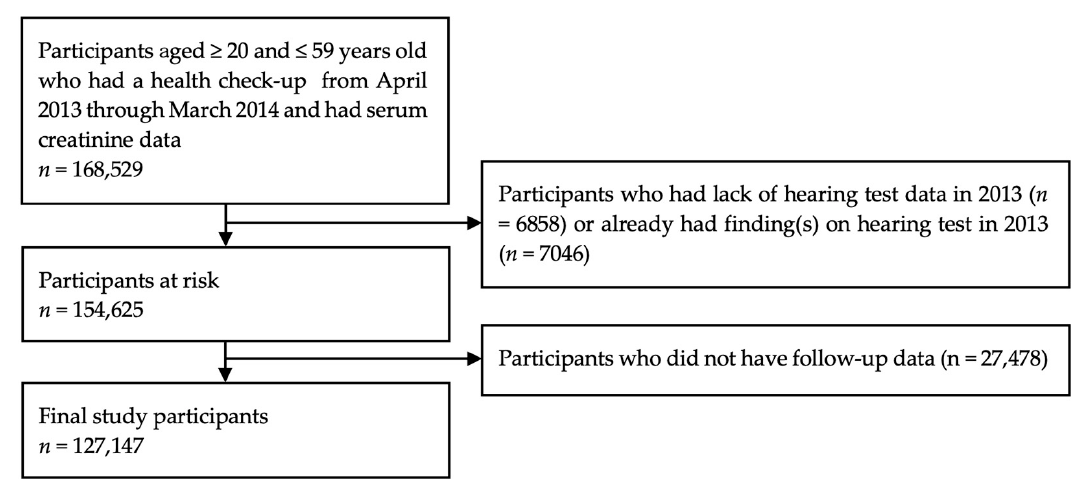
Figure 1. Participants flow.